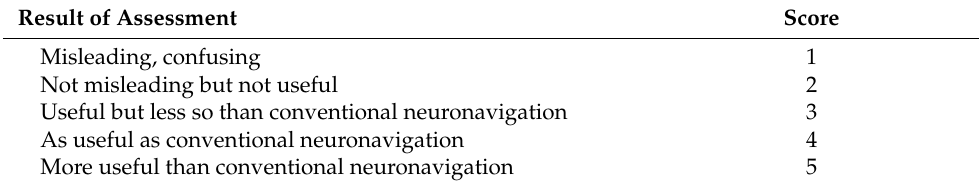
Table 2. Scale for assessment of AR navigation.